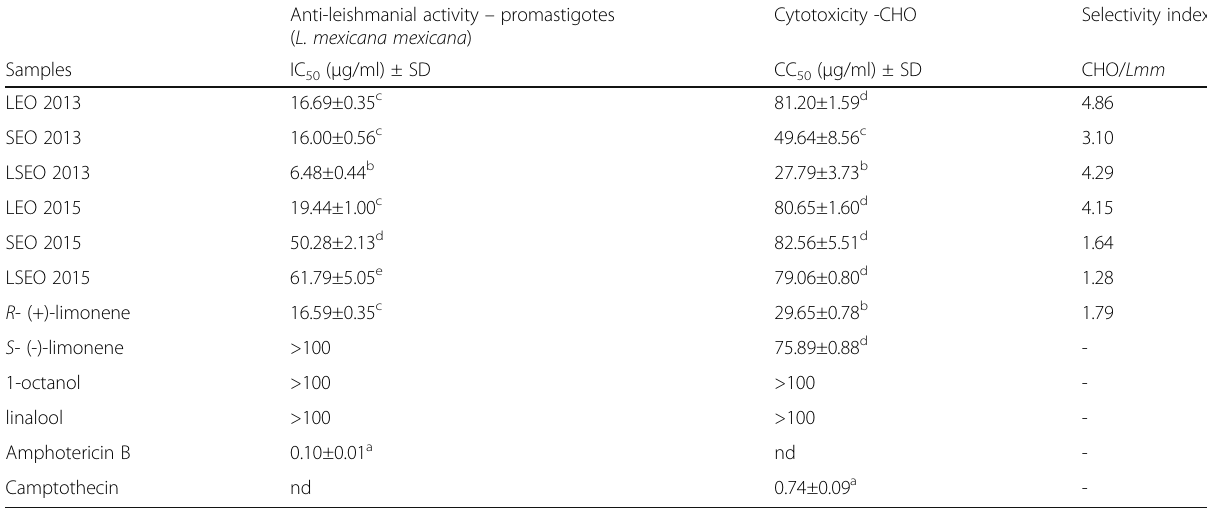
Table 2 Anti-leishmanial (IC 50 ±SD) and cytotoxic activity (CC 50 ±SD) of essentials oils, some of their components and the positive controls Anti-leishmanial activity – promastigotes ( L. mexicana mexicana